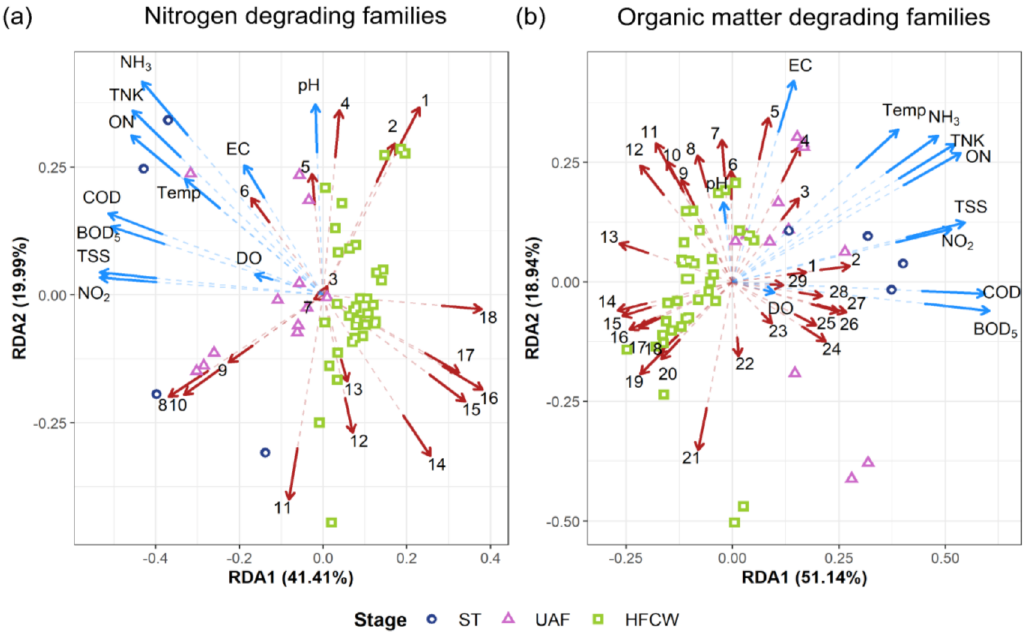
Figure 9. Redundancy analysis (RDA) showing correlations between physicochemical parameters and selected bacterial families ( a ) RDA for nitrogen degrading families, ( b ) RDA for organic matter degrading bacteria families. Each blue vector represents a physicochemical parameter and each red vector represents a bacterial family. Table 2 presents the bacterial families assigned to each